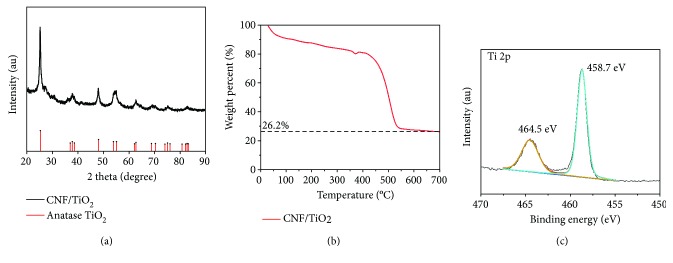
(a) The XRD pattern of CNF-TiO2 after pyrolysis at 700°C; (b) TG pattern of CNF-TiO2 under air atmosphere; (c) XPS of Ti 2p in CNF-TiO2.